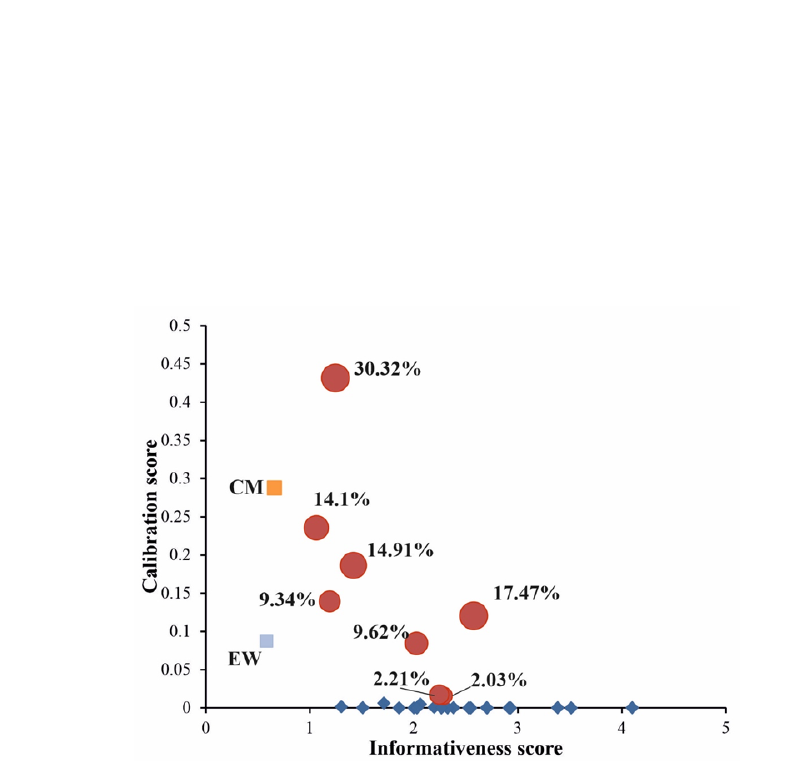
Figure A1: Graph summarizing the calibration/informativeness scores of the experts (red circles and blue dia- monds) and the CM and EW Decision Makers (squares). Regarding the CM, blue diamonds are unweighted experts while the size of the red circles is proportional to the expert’s weight.